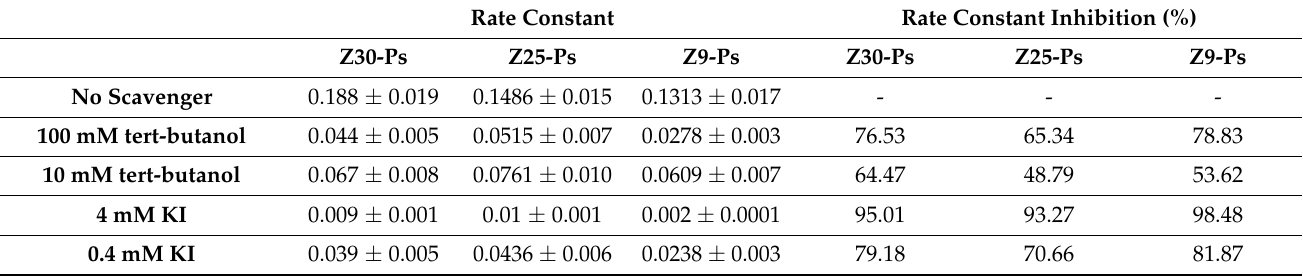
Figure 6. Trend of first-order kinetics following selective inhibitions with tert-Butanol and KI. Values refer to Z25-Ps. Table 2. k obs as a function of the particle sizes of ZnO. Comparison with the various inhibitions. 0.01 < p < 0.05 for Z30-Ps vs. Z25-Ps and for Z30-Ps vs.